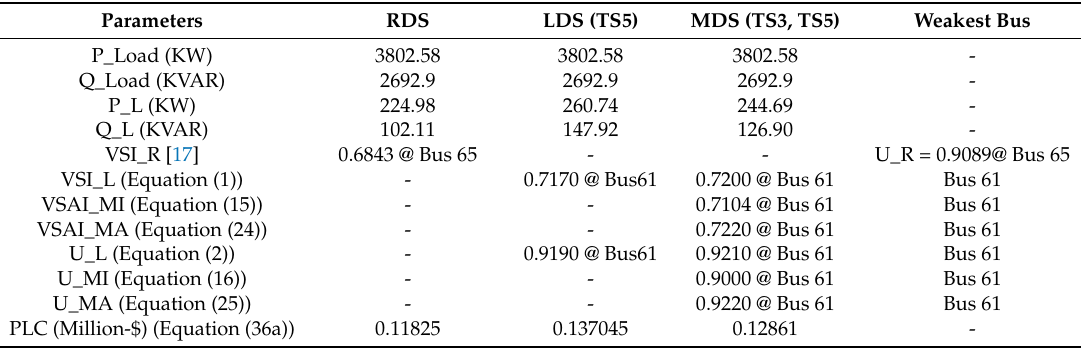
Table 4. Results of proposed planning approach without DG units (Base Case 0b).